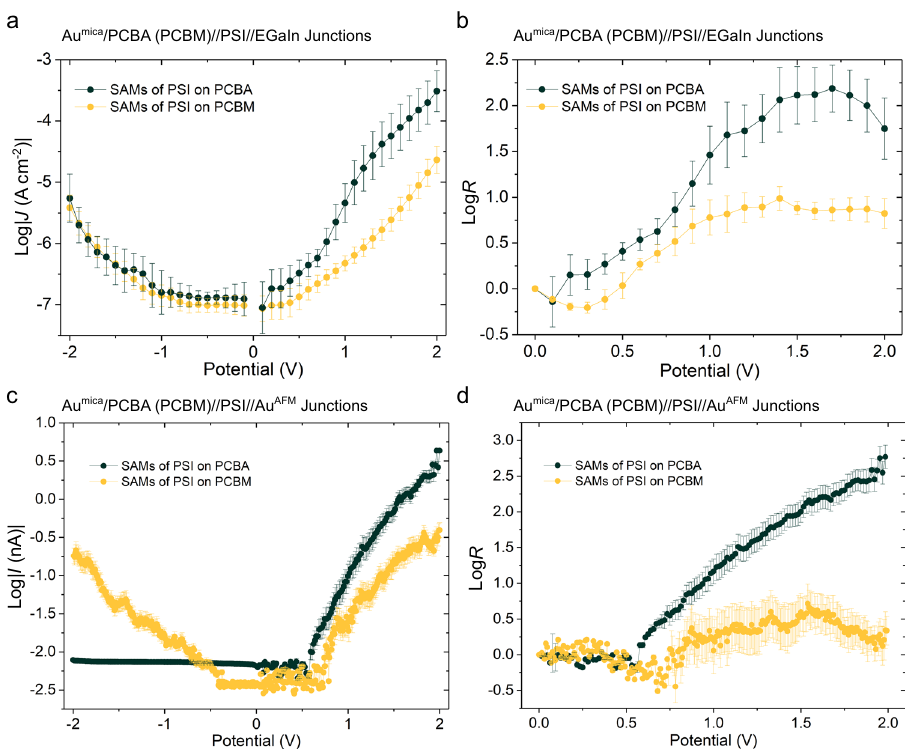
Fig. 4 Characterization of the charge-transport properties of the SAMs of PSI on different linkers. a Plots of log| J | versus potential of Au mica /PCBA (PCBM)//PSI//EGaIn junctions. b Plots of log R versus potential of Au mica /PCBA (PCBM)//PSI//EGaIn junctions. c Plots of log| I | versus potential of Au mica /PCBA (PCBM)//PSI//Au AFM junctions. d Plots of log R versus potential of Au mica /PCBA (PCBM)//PSI//Au AFM junctions. Error bars represent 95% con fi dence